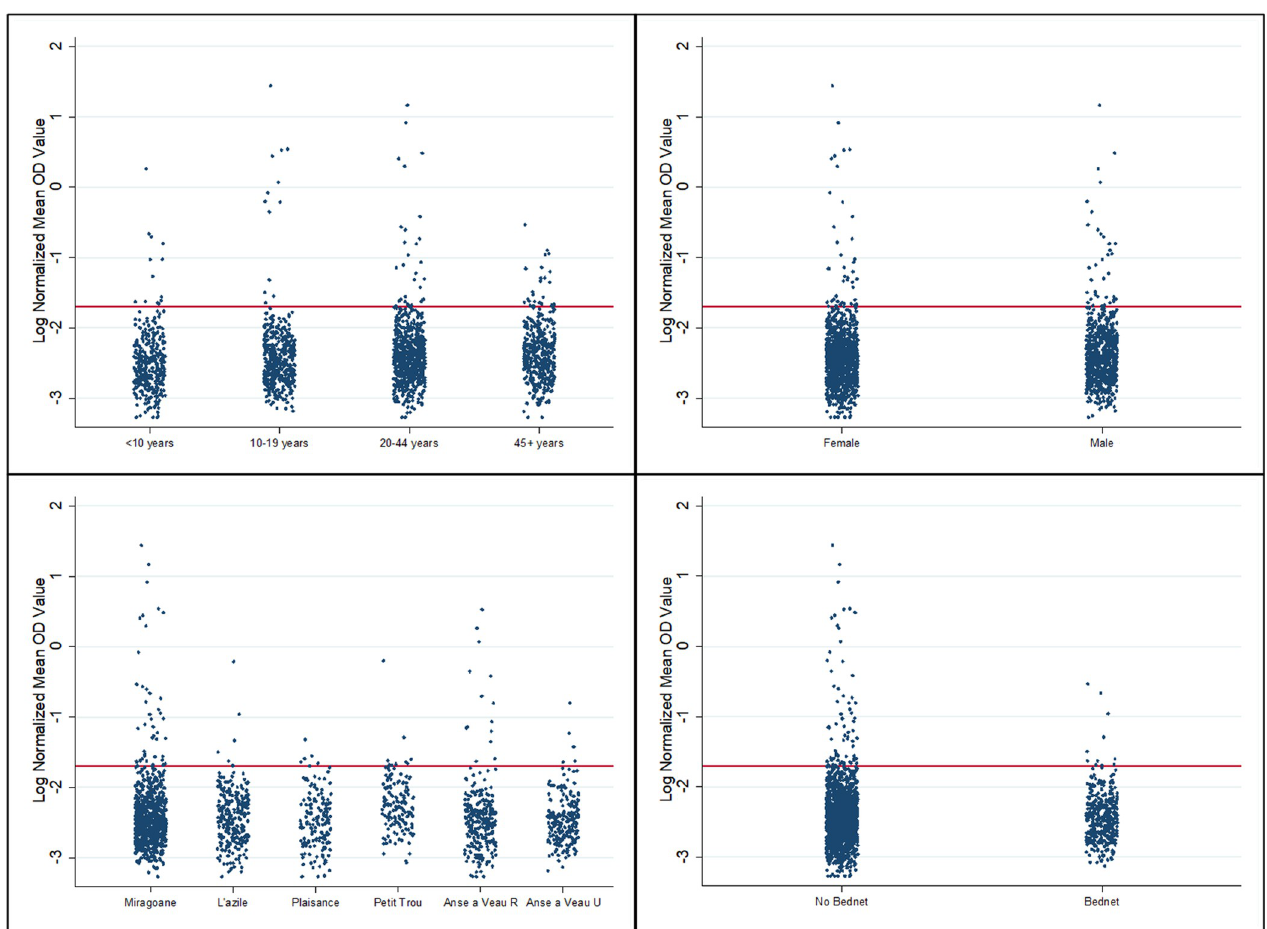
Fig 4. Log normalized mean optical density (OD) values for IgG4 antibodies against the recombinant Wb123 antigen by participant characteristics. Red line indicates cutoff for seropositivity.